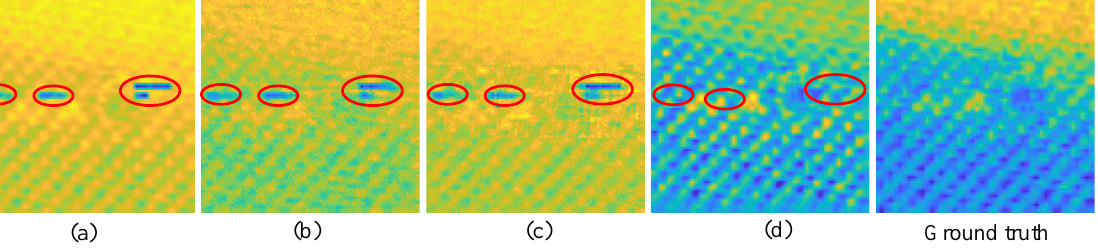
Figure 11. Denoising ability of the proposed RootsNet. ( a ) A raster scan image which has wrong data (highlighted in red circles); ( b ) OMP imaging results; ( c ) block OMP imaging results; ( d ) RootsNet imaging results.